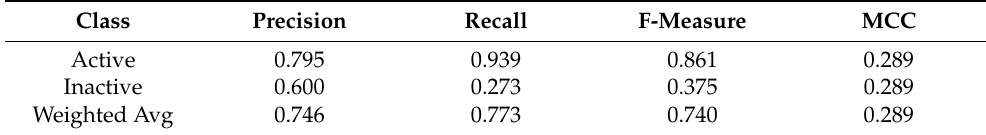
Table 2. Predicted values for the test set of a random forest